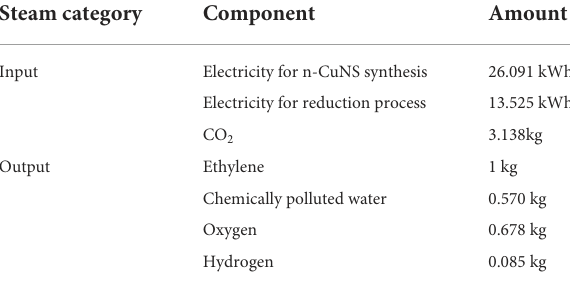
TABLE 3 LCI for the electrochemical reduction of CO 2 to ethylene at lab scale (Ai et al.,